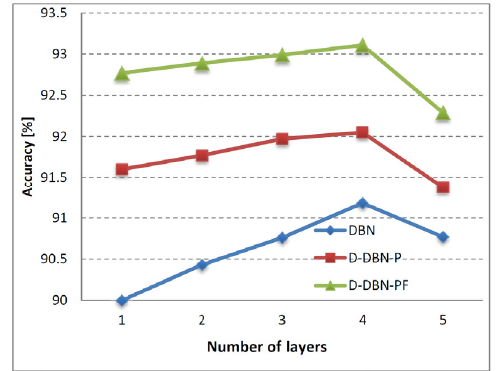
Fig. 5. Classification accuracies versus numbers of layers for the Pavia University data set.